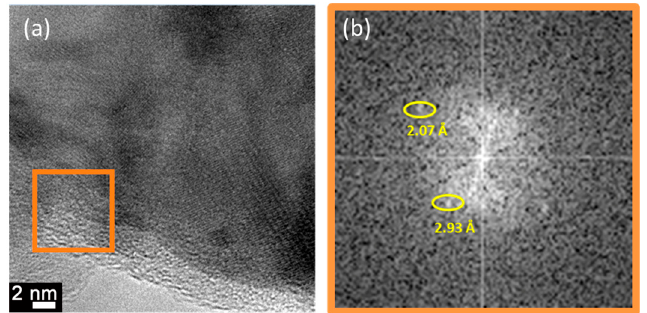
Figure 4. ( a ) HRTEM image of Cu–12Al–7Ni (wt.%) thin film grown on MgO; ( b ) FFT of the selected zone (orange square) in ( a ).